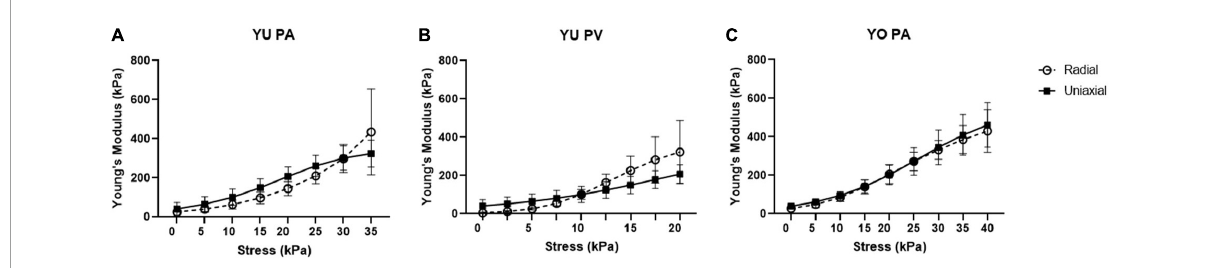
FIGURE6 Young’s modulus vs. stress for radial and uniaxial testing methods. Graphs are shown for (A) Yucatan piglet pulmonary artery (PA), (B) Yucatan piglet pulmonary valve (PV) region, and (C) Yorkshire pulmonary artery (PA). There is no significant difference in Young’s modulus measurements for a given stress between the two